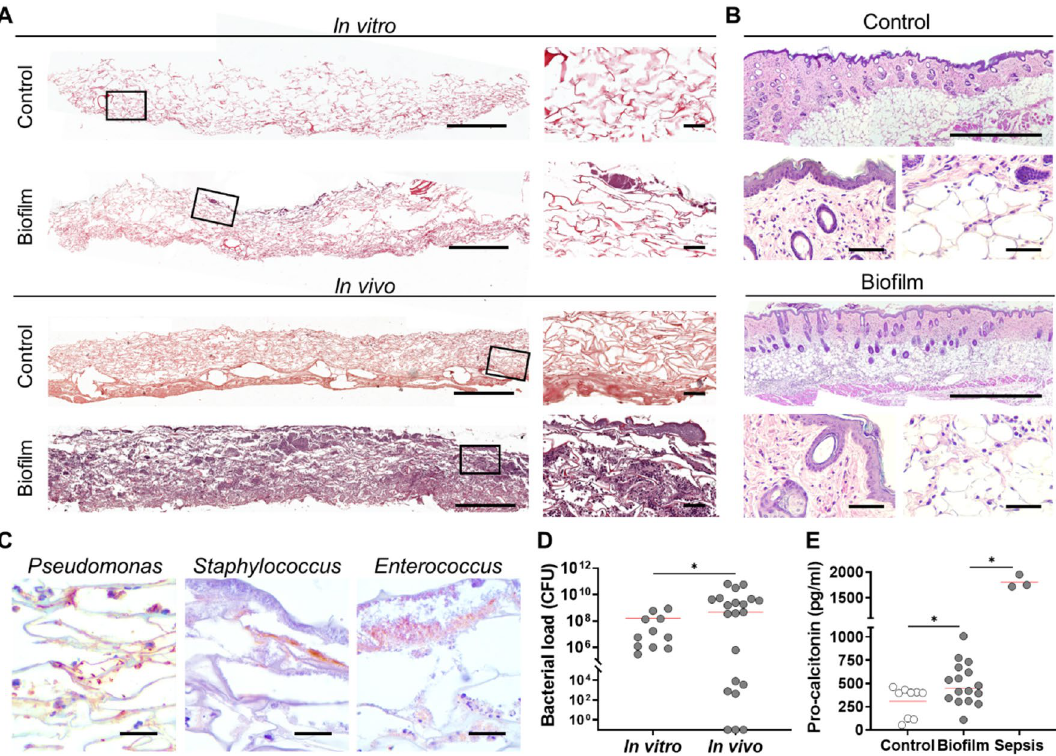
Figure 6. Infection of wounds after implantation of biofilm-containing scaffolds. ( A ) Histological sections from scaffolds in vitro (pre-implantation), and in vivo (10 days of post-implantation) were stained with H&E. ( B ) Histological sections from skin samples of the wound edge were stained with H&E, showing infiltration of leucocytes in the adipose tissue (right lower panels) but not in the epidermal layer (left lower panels). ( C ) Histological immune staining, showing bacterial aggregates corresponding to each bacterial species. ( D ) Scaffold samples were diluted and plated in TSS agar for CFU determination, showing over 10 6 CFU/gr in vitro (N = 11) and 10 9 CFU/gr for the in vivo group (N = 21). ( F ) Pro-calcitonin levels were measured from plasma of animals implanted with sterile scaffolds (control), biofilm-containing scaffolds with antibiotics (Biofilm), and biofilm-containing scaffolds without antibiotics provoking septicemia (Sepsis). Scale bar for A represents 1000 µm (left) and 60 µm (right); for B represents 1000 µm (upper) and 60 µm (lower); for C represents 20 µm. Individual values and mean (red line) are plotted. Unpaired t-test, comparing with corresponding previous group. *p <